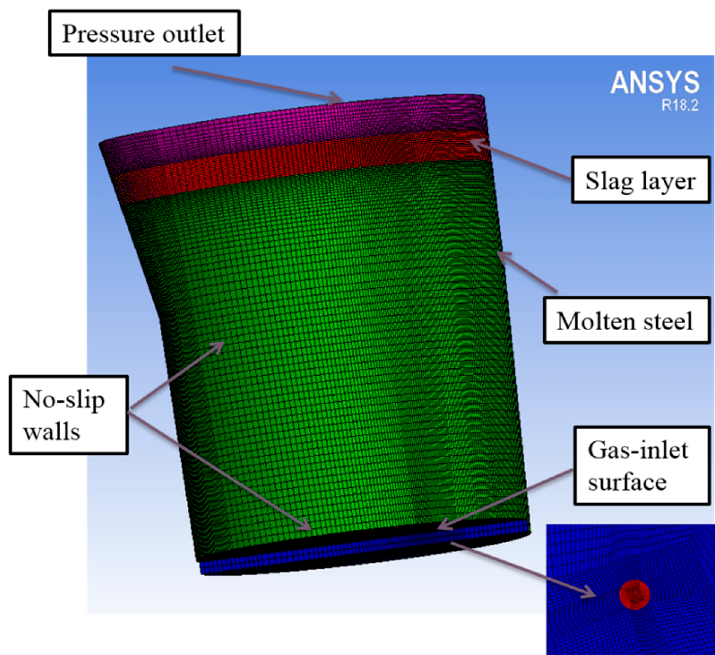
Figure 1. The geometry, mesh and boundary conditions of the ladle studied.